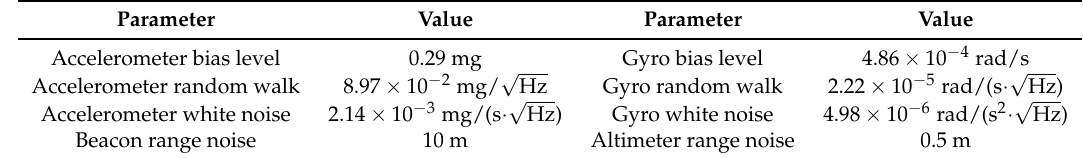
Table 2. Sensor parameters (1 σ